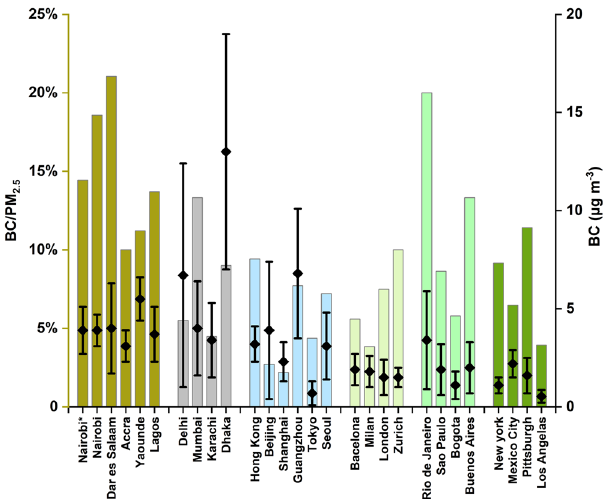
Fig. 3 Comparison of BC/PM 2.5 ratio (columns; %) and the corresponding BC concentrations (diamonds, with error bar as the standard deviation) reported in major cities globally. Different colours/shades are used to represent cities in different regions for ease of comparison. Nairobi * refers to this study. A detailed compilation and references are provided in SI Table S2. Fig. 4 Year-round variations in BC source contribution in Nairobi.